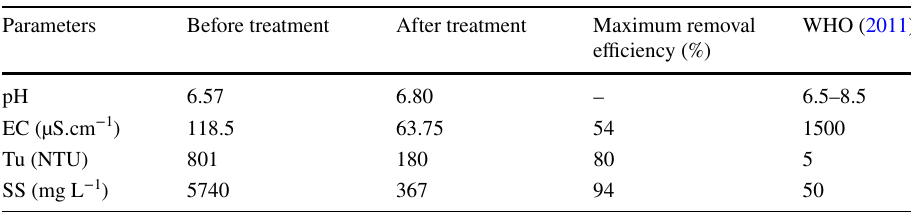
pH Potential Hydrogen; EC Electrical Conductivity; Tu Turbidity; SS Suspended solids; WHO World Organization